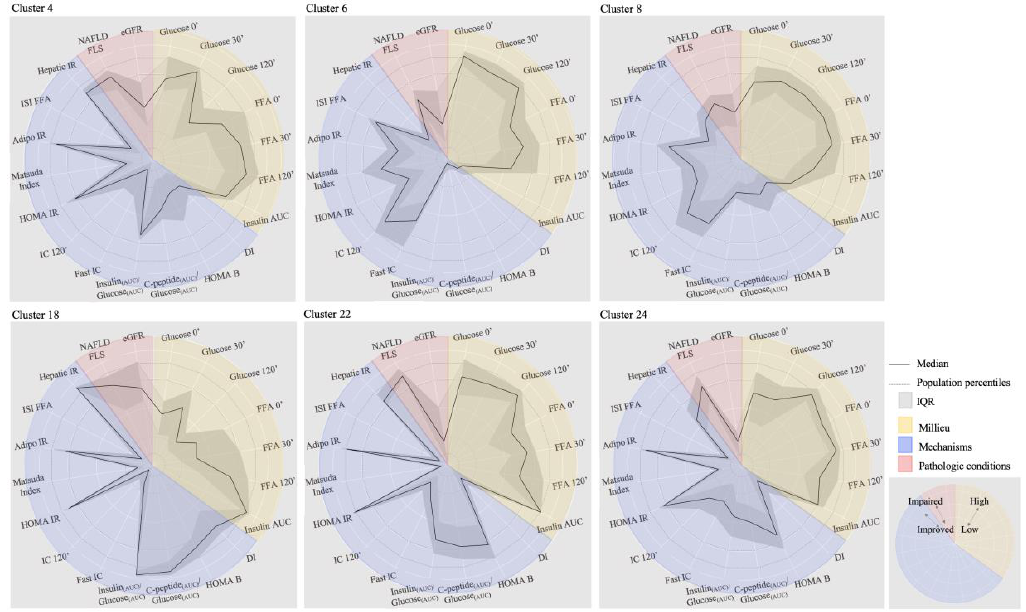
Figure 4. Metabolic footprint of Clusters 4, 6, 8, 18, 22, and 24 is shown in radar plots. The considered percentile ranges to profile the clusters (10th, 25th, 75th, and 90th) are represented in doted circumferences (light grey). Represented parameters are grouped in milieu (yellow), mechanisms (blue), and pathologic conditions (red). In the footprint higher deviations from the center in the milieu correspond to higher exposure, in mechanisms to more severe affection and to the presence and severity of pathological conditions. IQR-Interquartile range.